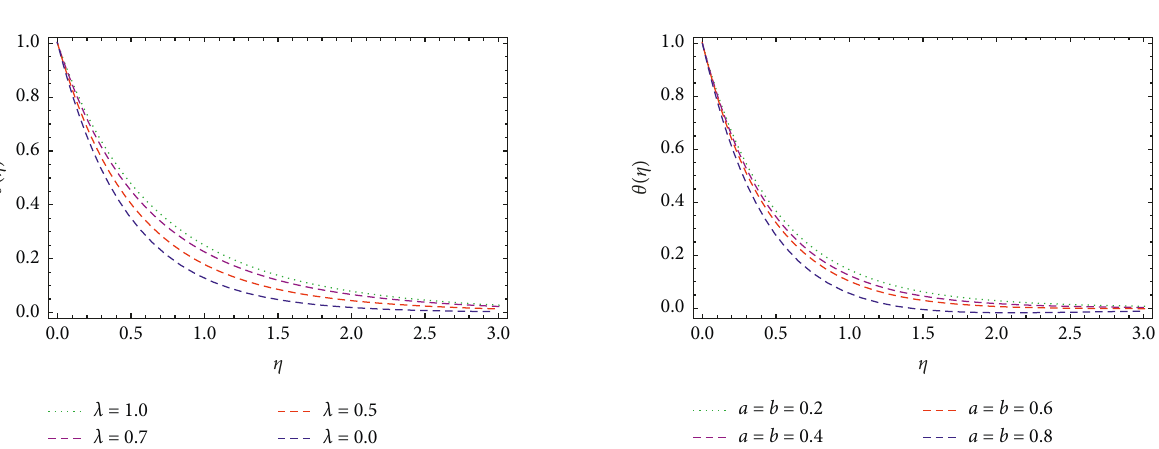
Figure 9: The influence of the temperature profile for different values of λ , when K � 0 . 1 , f w � 0 . 3 , β � 0 . 2 , Pr � 5 . 0 ,E c � 0 . 4 , and a ∗ � b ∗ � 0 . 2 .